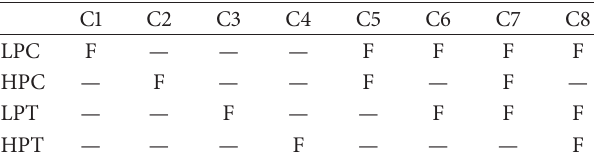
Table 2: Different fault classes setting.